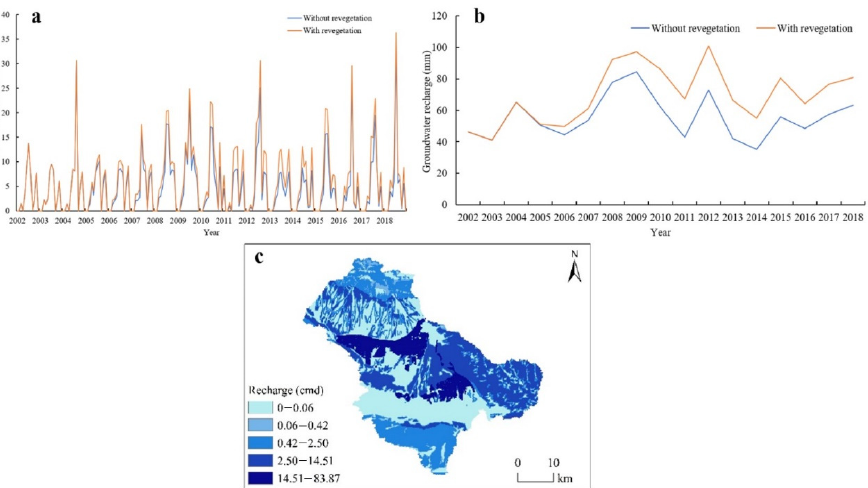
Figure 15. ( a ) Monthly and ( b ) yearly groundwater recharge with and without revegetation; ( c ) yearly average groundwater recharge after revegetation in space.